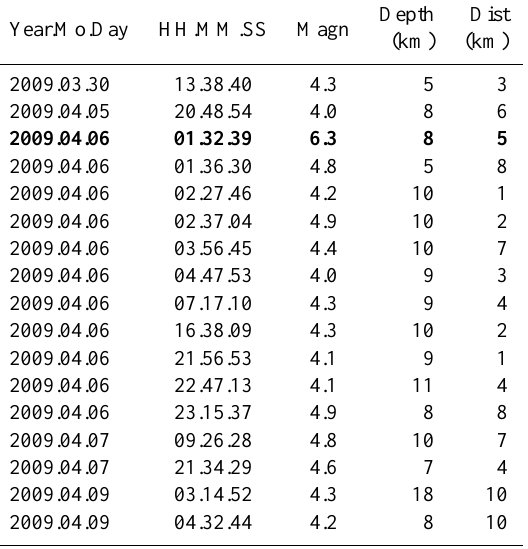
Table 2. Seismic events with less than 10km distance to L’Aquila EQ extracted from USGS. The main stroke is indicated in bold let-